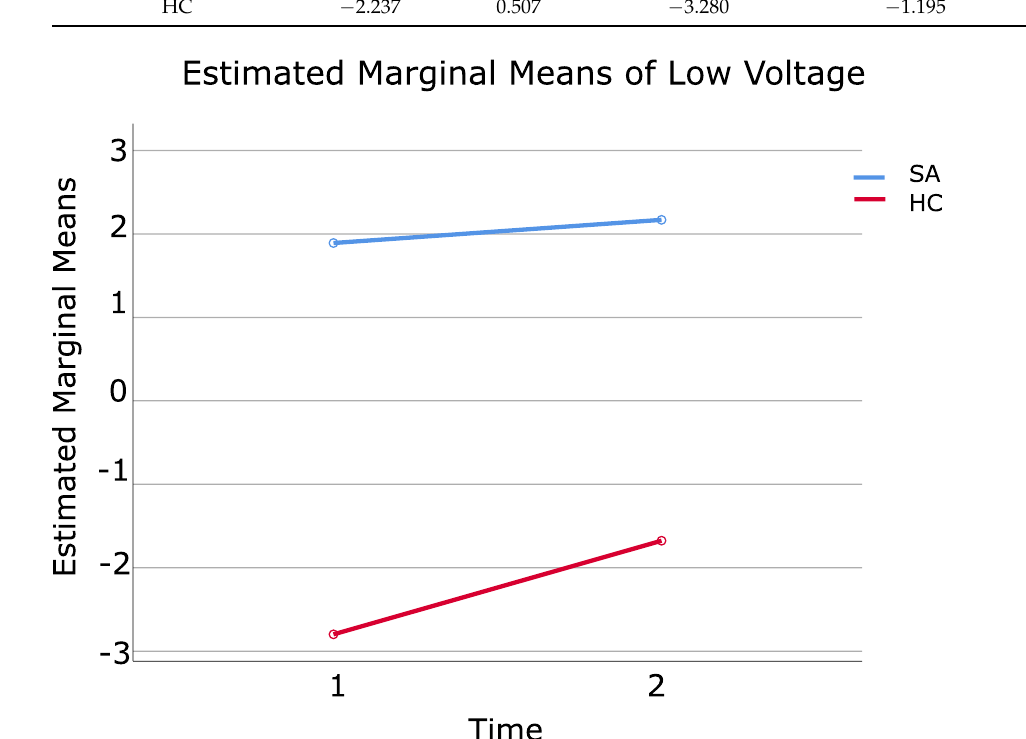
Figure 4. Displayed means for low voltage measured at Time 1 (baseline) and Time 2 (after LTH) for SA (shown in blue color) and HC (shown in red color) groups.